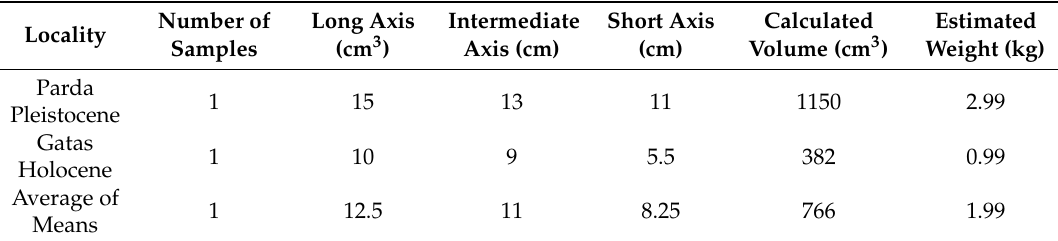
Table 2. Summary data from Appendix A (Tables A1 and A2) listing values for the largest single rhodolith measured across long, intermediate, and short axes, and corresponding values for volume and estimated weight. Note: the density magnesium-rich carbonate at 2.6 gm / cm 3 applies uniformly to calculations for weight